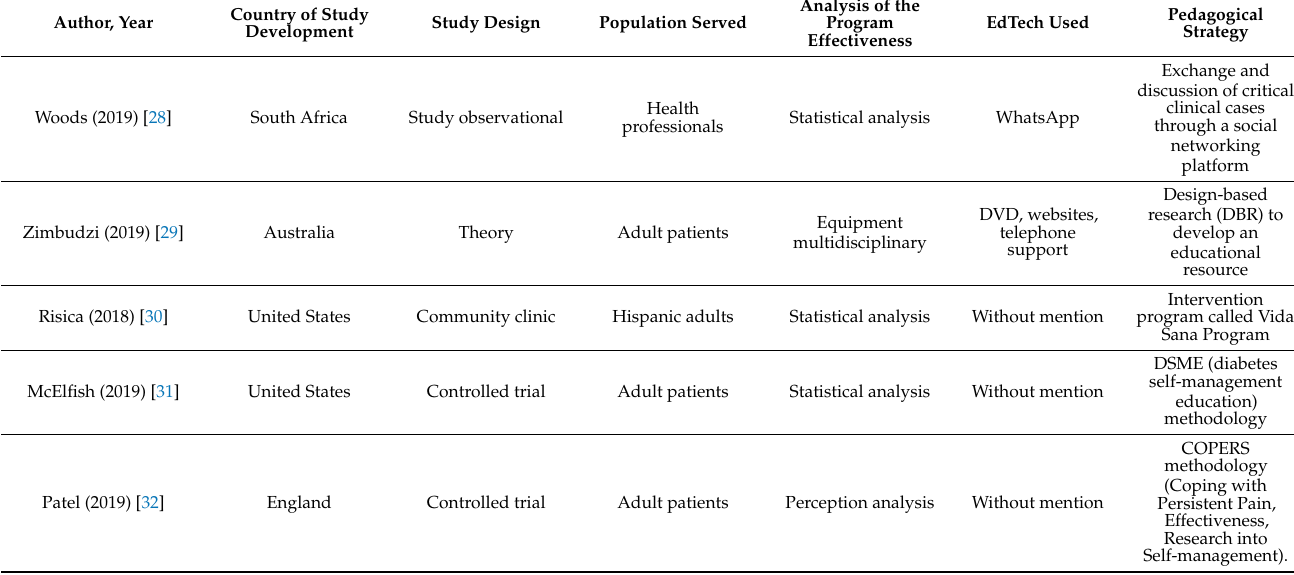
Table 2. Summary of included